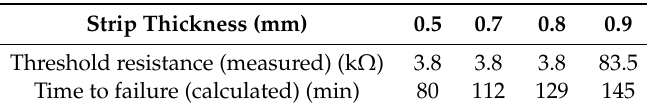
Table 1. Estimated time of failure for each strip.